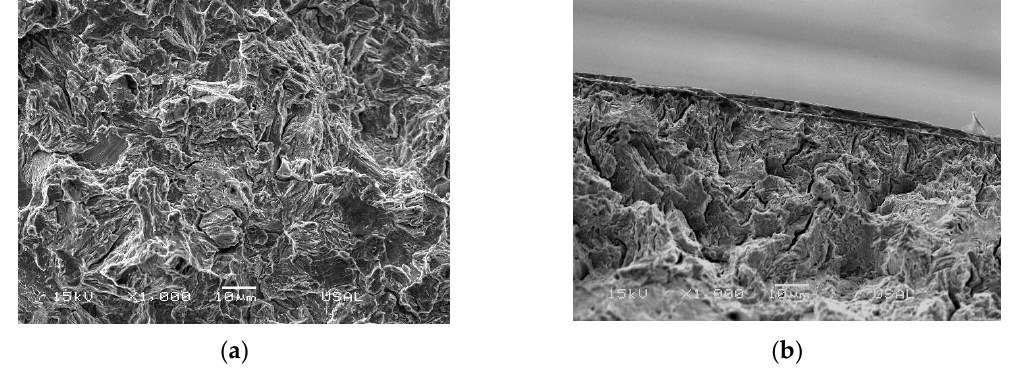
Figure 6. Hydrogen-assisted micro-damage (TTS) in wires after CERT tests: ( a ) hot rolled steel, speed type 1 (Figure 4a); ( b ) prestressing steel, speed type 2 (Figure 5c).